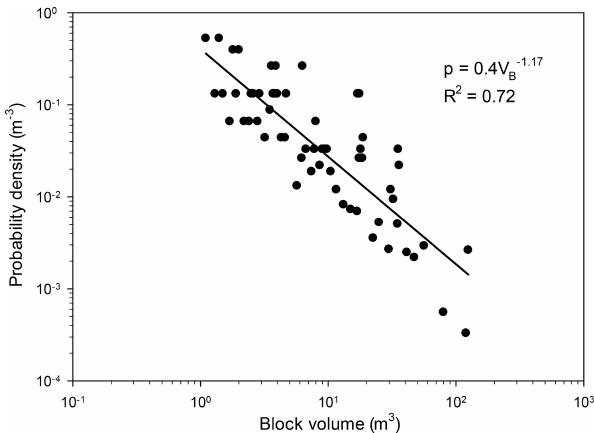
Figure 6. Probability density function (PDF) of field-measured, D > 1m 3 , block volumes ( N = 76).